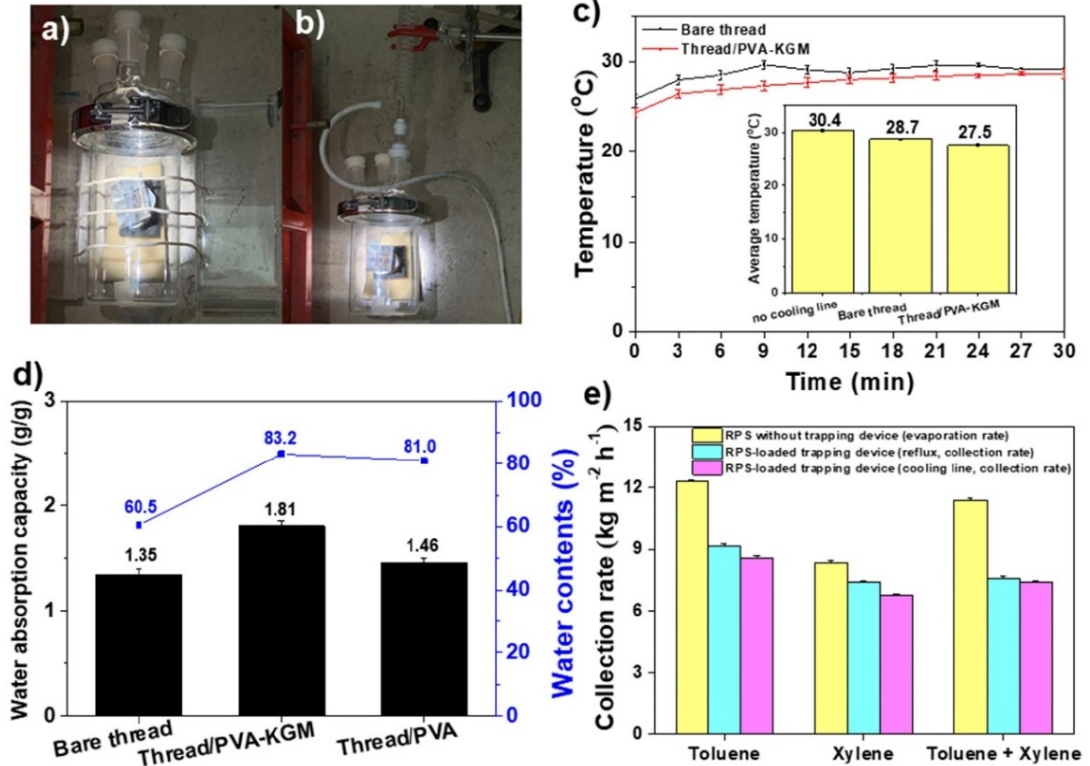
Figure 5. Images of the HNS trapping device (RPS equipped with an Al mirror) installed with ( a ) cooling lines and ( b ) a reflux condenser. ( c ) Temperatures of the rooftop of a glass chamber installed with cooling lines (polyester thread and polyester thread/PVA-KGM). ( d ) Water absorption capacity and water content of thread, thread/PVA, and thread/PVA-KGM. ( e ) Collection rates of the RPS-loaded HNS trapping device with different cooling systems for toluene, xylene, and toluene–xylene.